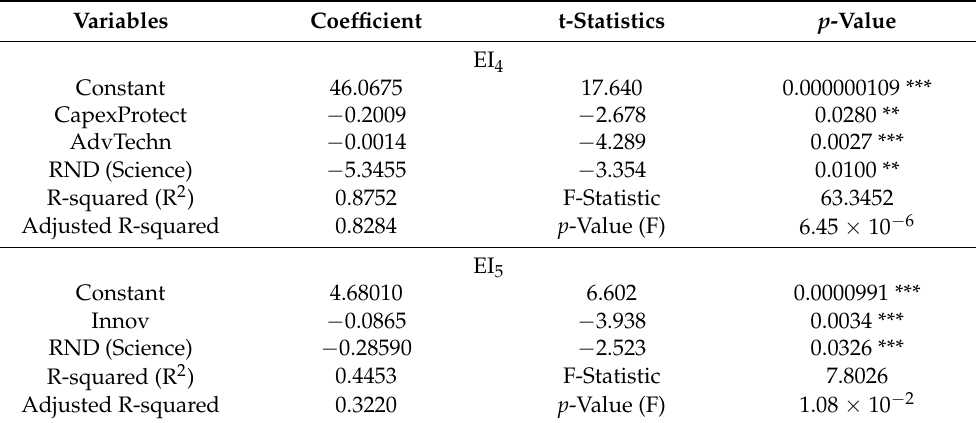
Table 9. Results of OLS